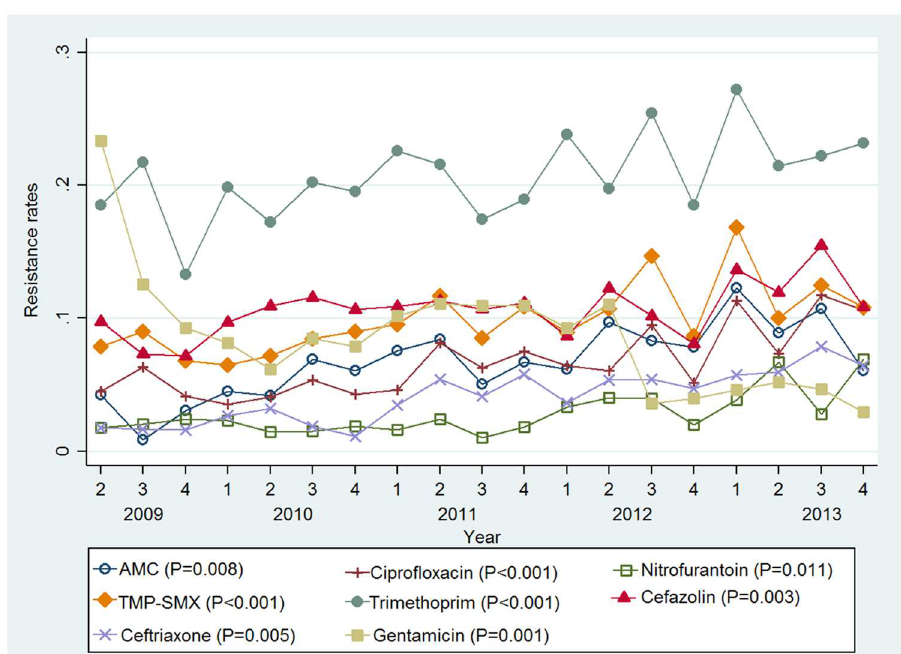
Fig 2. Seasonal antimicrobial resistance rates for E . coli UTIs. 1 = Summer; 2 = Autumn; 3 = Winter; 4 = Spring. P = significance level for an increasingtrend. AMC = Amoxycillin-clavulanate; TMP-SMX = Trimethoprim-sulphamethoxazole